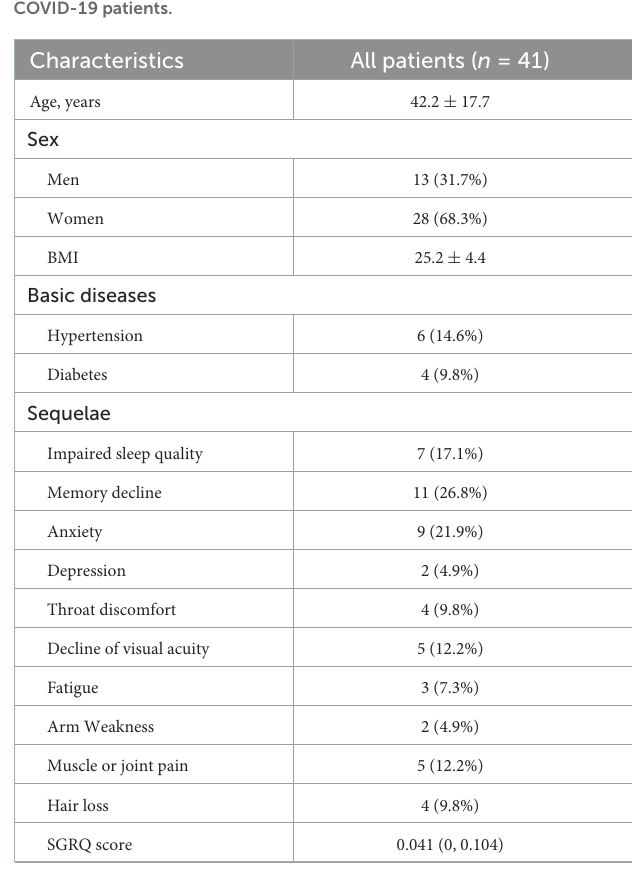
TABLE 1 Demographic and clinical characteristics of the enrolled COVID-19